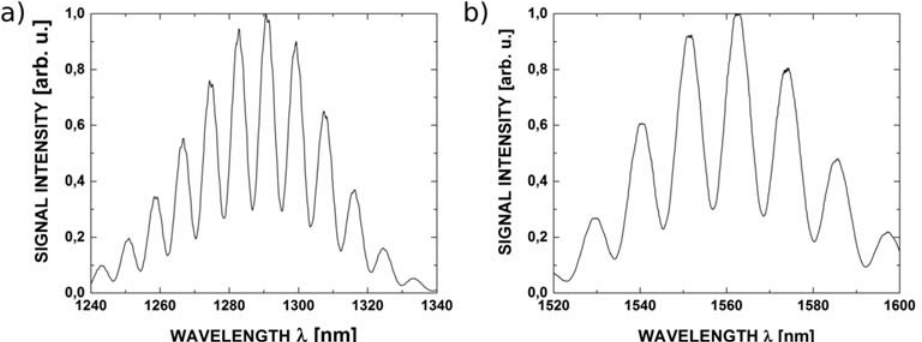
Figure 10. Representative measured spectra from Fabry-Pérot interferometer with 200 nm ZnO layers (cavity dimension: 100 µm) for source wavelengths: ( a ) 1300 nm; ( b ) 1550 nm.